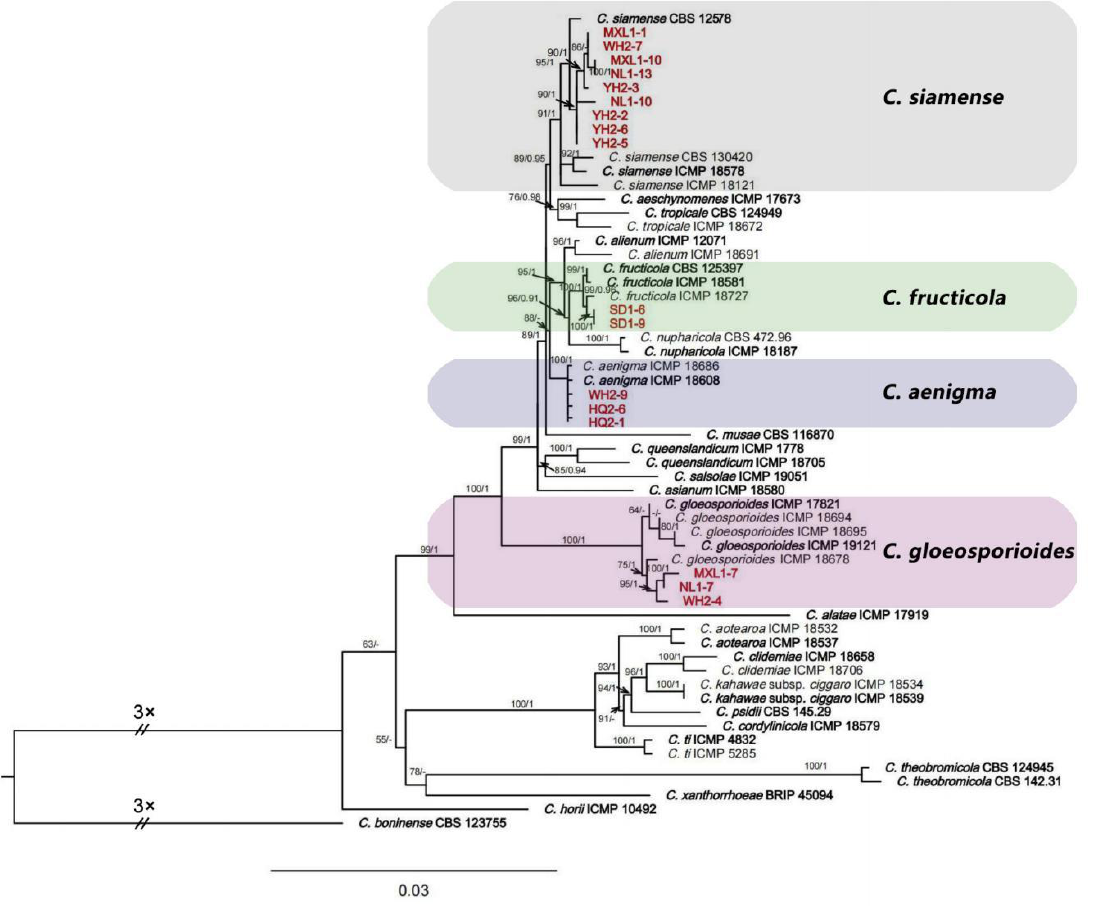
Figure 2. Phylogenetic relationship of Colletotrichum isolates (YH2-2, YH2-3, YH2-5, YH2-6, HQ2-1, HQ2-6, WH2-4, WH2-7, WH2-9, SD1-6, SD1-9, NL1-7, NL1-10, NL1-13, MXL1-1, MXL1-7, MXL1-10) from Salix babylonica with related taxa derived from the concatenated sequences of ITS, ACT , CHS-1 , TUB2 , CAL , and GAPDH loci using a maximum likelihood estimation and Bayesian inference analyses. Bootstrap support values (ML ≥ 50) and Bayesian posterior probability (PP ≥ 0.90) are shown at the nodes (ML/PP). Colletotrichum boninense (CBS 123755) is an outgroup. Bar = 0.03 substitutions per nucleotide position. Bold indicates ex-types. The red color text indicates strains of this study.